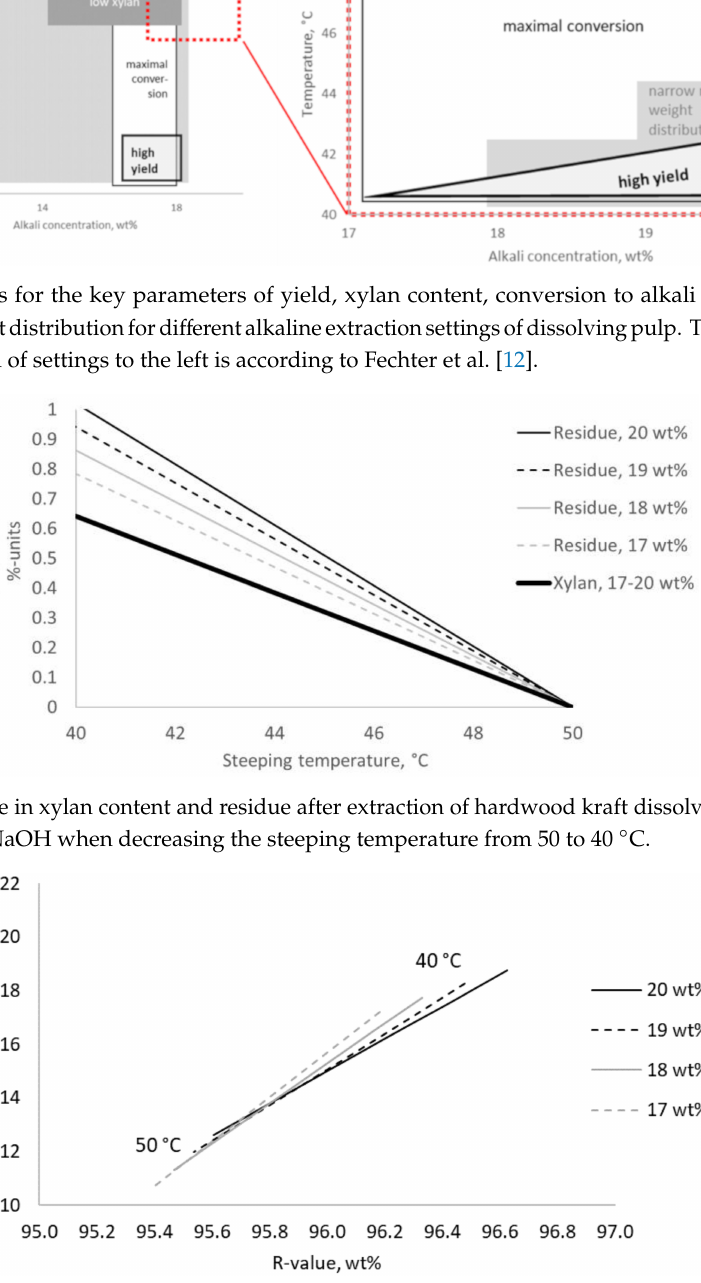
Figure 6. Modeled correlation between residue after extraction of hardwood kraft dissolving pulp with aqueous NaOH at di ff erent concentrations and temperatures, expressed as R-value, and the xylan content left in its